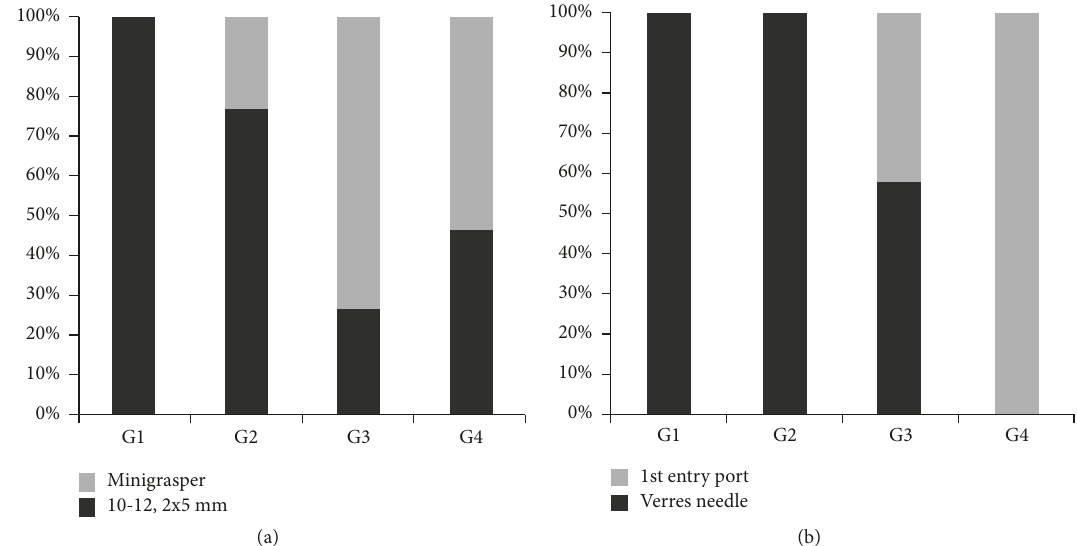
Figure 2: Operative data A. (a) Increasing usage of the minigrasper in groups 3 and 4. (b) Switch from Verres needle approach to Fios 1st entry port.